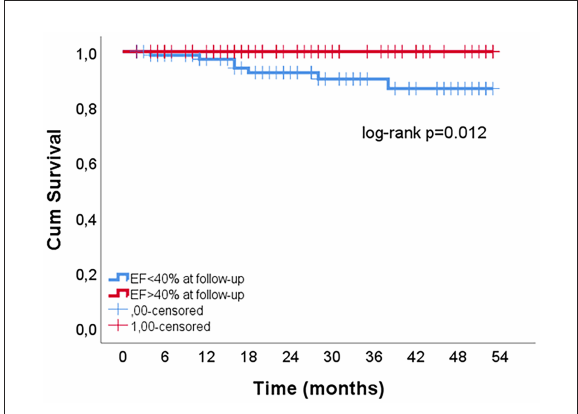
FIGURE2 The influence of EF improvement on mortality risk in patients with EF < 40% at hospital discharge. TABLE 2 Multivariate logistic regression of factors associated with EF < 40% at the time of hospitalization.